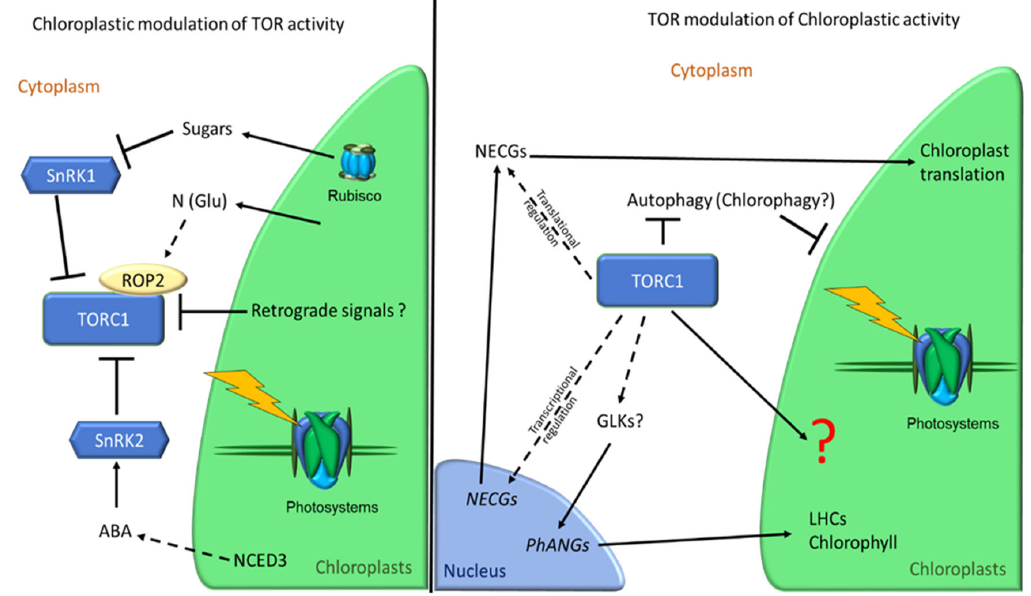
Figure 1. Reciprocal regulation between TOR and chloroplast activity. Chloroplast activity influ ‐ ences the activity of the TOR complex (TORC1) through the production of sugars (glucose and tre ‐ halose 6 ‐ phosphate), through the release of amino acids in the remobilization of carbon and nitrogen (glutamine) and through the biosynthesis of phytohormones (ABA). On the contrary, TORC1 activ ‐ ity influences different aspects of chloroplast physiology (translation, photosynthetic efficiency, chlorophyll concentration) by still unknown mechanisms, which might involve the transcriptional and translation control of NECGs (including PhANGs) and the regulation by phosphorylation of ATG1 and ATG13, involved in autophagy and probably in chlorophagy. Funding: This research was funded by the University of Turin, Fondi per la Ricerca locale, to S.D., an AMU ATER position and the ANR funding G4Plast (ANR ‐ 17 ‐ CE13 ‐ 0005). Institutional Review Board Statement: Not applicable. Informed Consent Statement: Not applicable. Data Availability Statement: Not applicable. Acknowledgments: We would like to thank Benoit Menand (CNRS) for critical comments and Ben Field (CNRS) for scientific exchanges and improving the use of English in the text. Conflicts of Interest: The author declares no conflict of interest. The funders had no role in the design of the study; in the collection, analyses, or interpretation of data; in the writing of the manu ‐ script, or in the decision to publish the results. References 1.